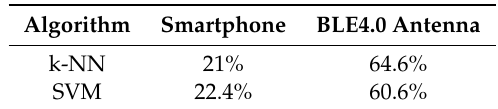
Table 1. Global accuracy for k-NN using mode (with k = 5) and SVM (with a quadratic polynomial kernel function) algorithms for transmission power Tx = 0x04. Best results are shown in